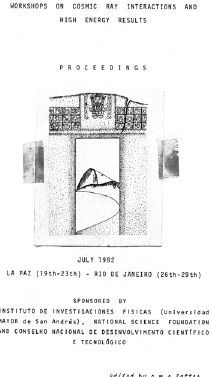
Figure 12. Cover of LaPaz and Rio de Janeiro proceedings.